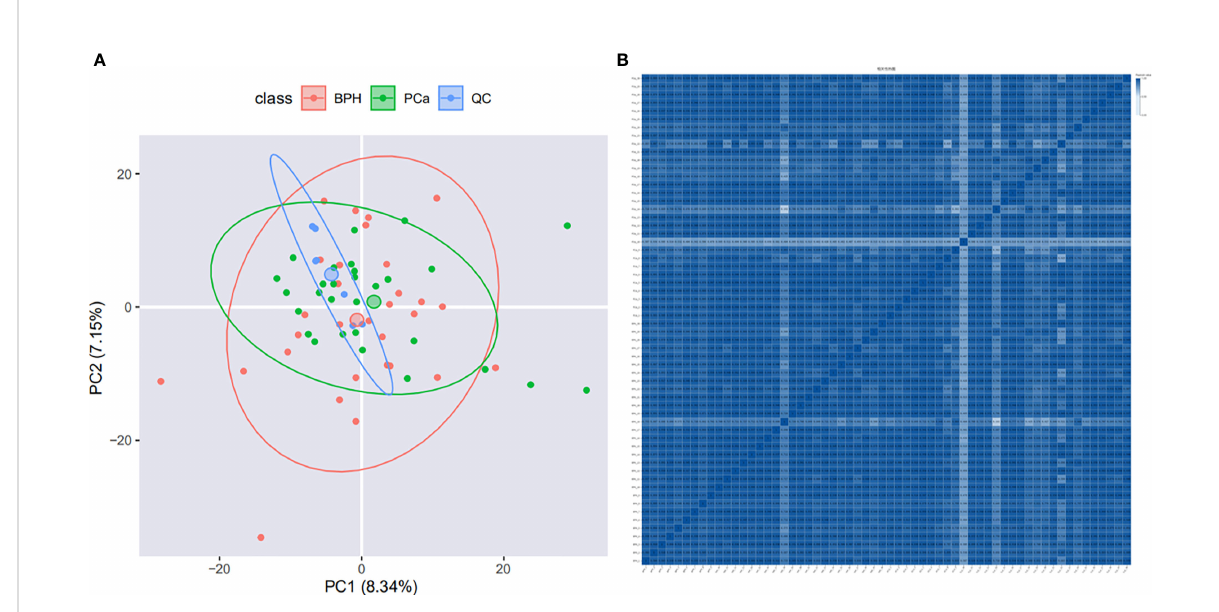
FIGURE 2 Quality control evaluation of DIA data. (A) PCA analysis. The X-axis is the fi rst principal component and the Y-axis is the second principal component. (B) Heat map of sample correlation analysis. Both X and Y axes represent samples. The color represents the correlation coef fi cient; the deeper color represents the higher